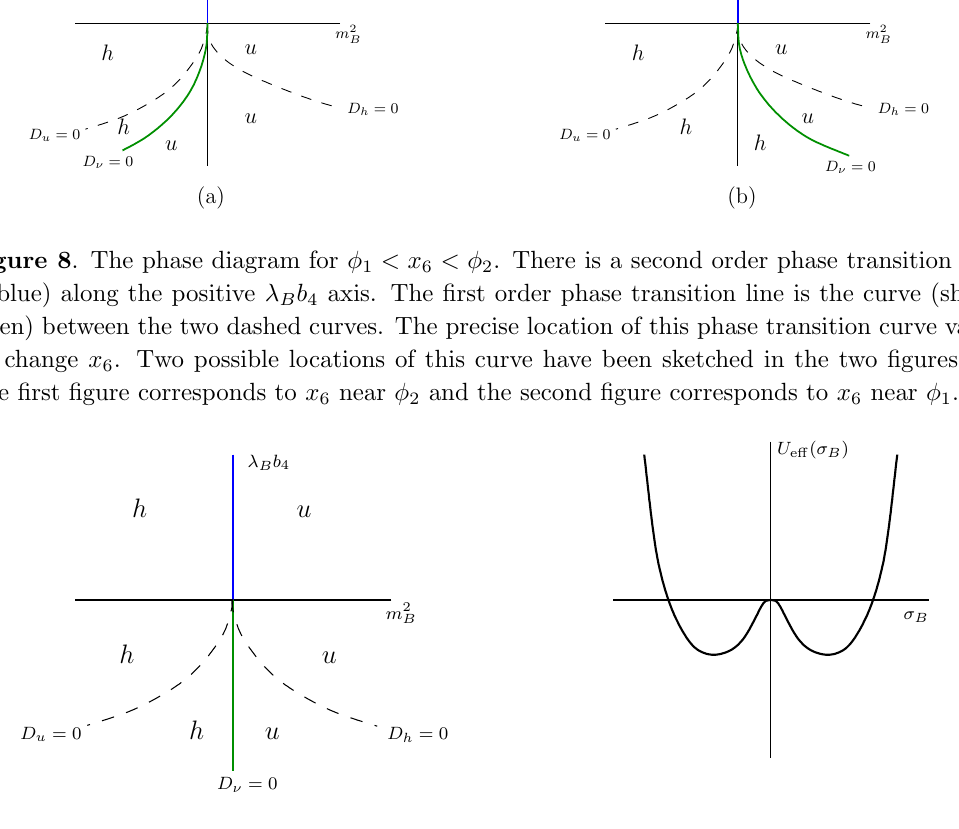
Figure 9 . The (cid:12)rst (cid:12)gure is the phase diagram for x 6 = 1 ( (cid:30) 1 + (cid:30) 2 ). The second (cid:12)gure is the 2 Landau-Ginzburg potential at the same value of x 6 for a point on the (cid:12)rst order phase transition line (green) corresponding to m 2 = 0 and some (cid:21) B b 4 < 0. B 3. m 2 negative: (cid:21) b positive or (cid:21) b negative with D negative: the graph of U 4 4 u B B B versus (cid:27) takes the form depicted in (cid:12)gure 7(c). The global minimum in the Higgsed B branch (positive (cid:27) ) is the only extremum of U ( (cid:27) ); this phase dominates the B B e(cid:11) phase